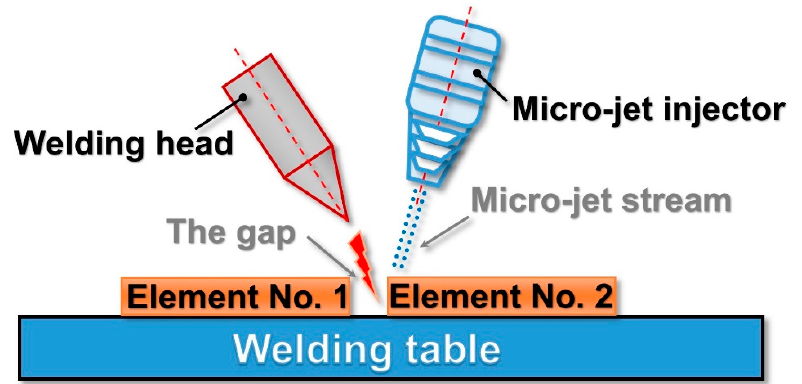
Figure 1. A scheme of Metal Active Gas (MAG) welding with micro-jet technique.